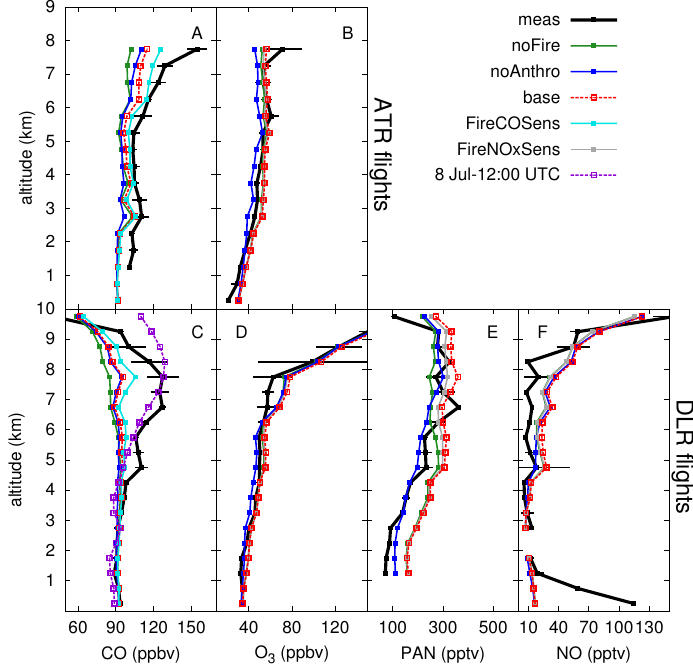
Fig. 6. Vertical profiles (averaged along flight tracks) including measurements of aged pollution compared to WRF-Chem results – measurements are in black, the model base run is in red, the noFire run is in green, and the noAnthro run is in blue. Two fire emission sensitivity runs are shown, the FireCOSens run is shown in teal (CO plot only) and the FireNOxSens run is shown in the ozone, PAN, and NO plots in gray. The points indicate mean values every 500m and the error bars show the standard deviation for the measurements. The flights included for the comparison are on 5, 7, and 8 July (ATR-42 flights) and on 4, 7, and 8 July (Falcon-20 flights). In addition, one vertical profile for CO extracted from the model in the region of the Falcon-20 aircraft (lat 61.1 ◦ N lon 41.5 ◦ W) on 8 July at 12:00UTC is shown in purple.